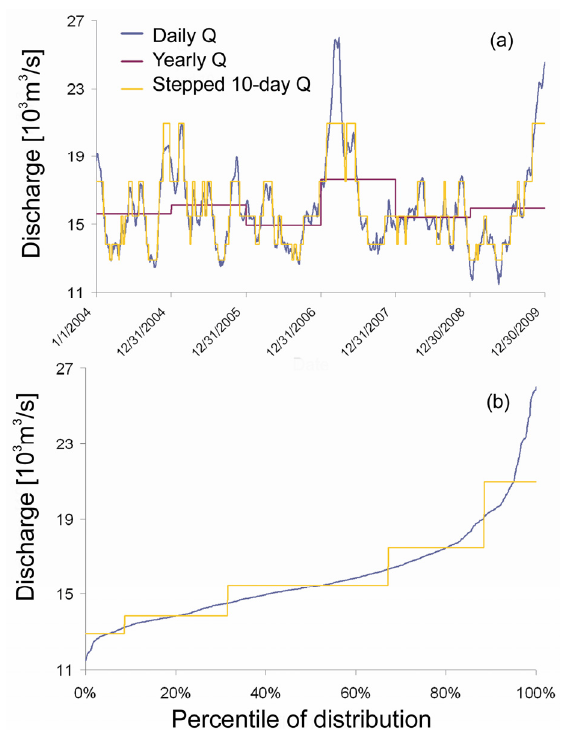
Figure 2. 2004–2009 discharges at the Parana River (station Chapeton): ( a ) discharge time series and ( b ) cumulative